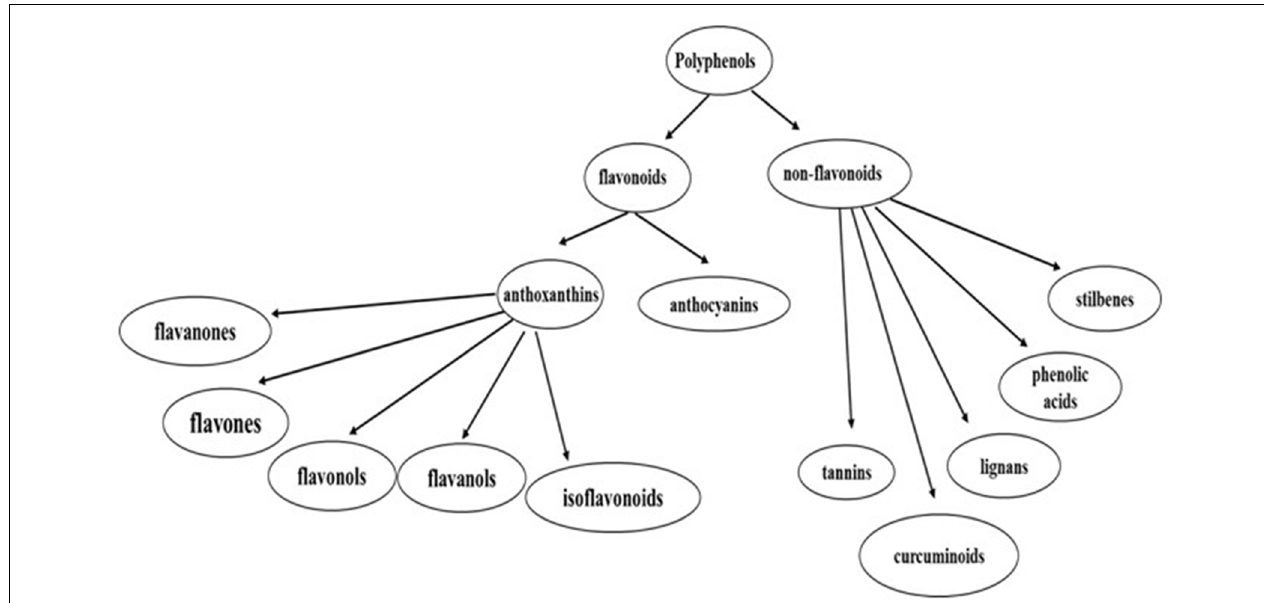
FIGURE 4 | Polyphenols classifications. PP are divided into two main groups of flavonoids and non-flavonoids (El Gharras, 2009; Lakey-Beitia et al.,